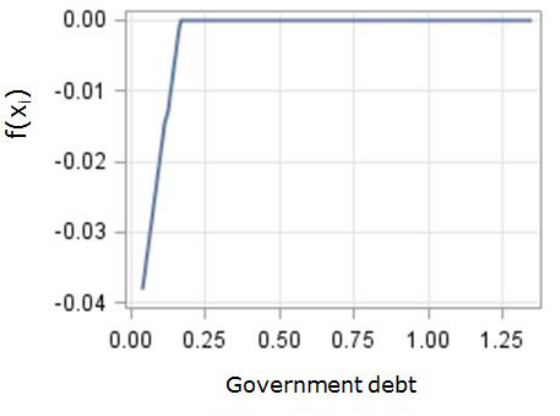
Figure 3: MARS EU13 additive model: dependence of growth on Government debt, as detected by the